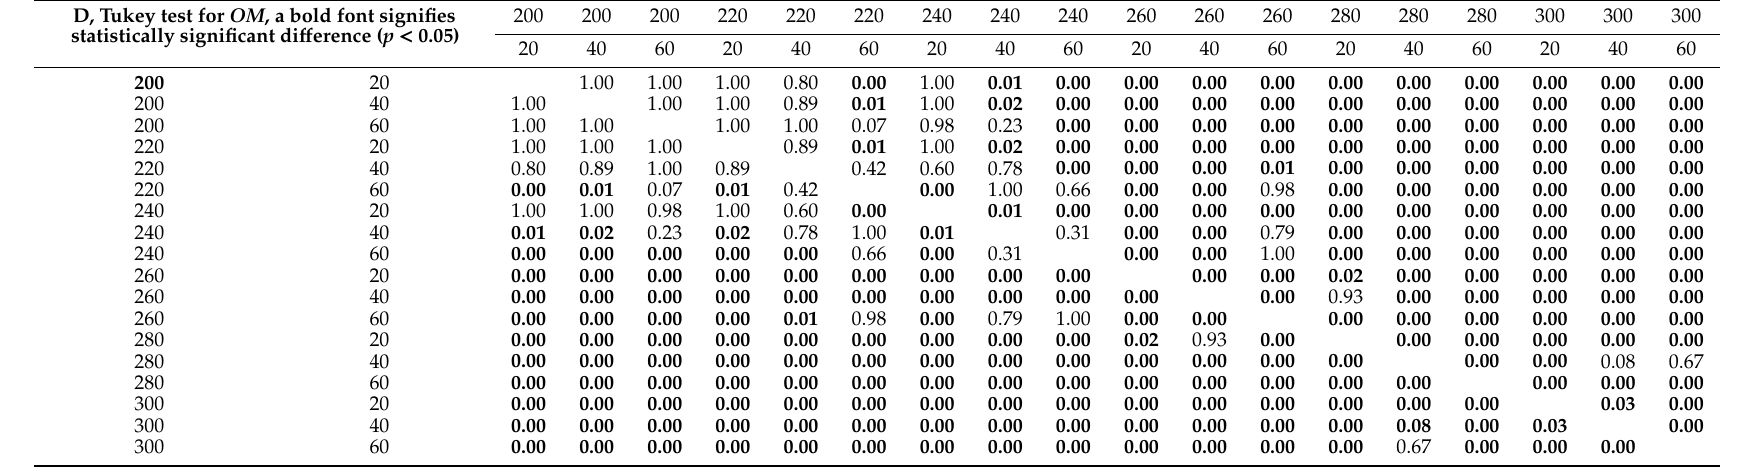
Table A9. Analysis of variance for organic matter content of